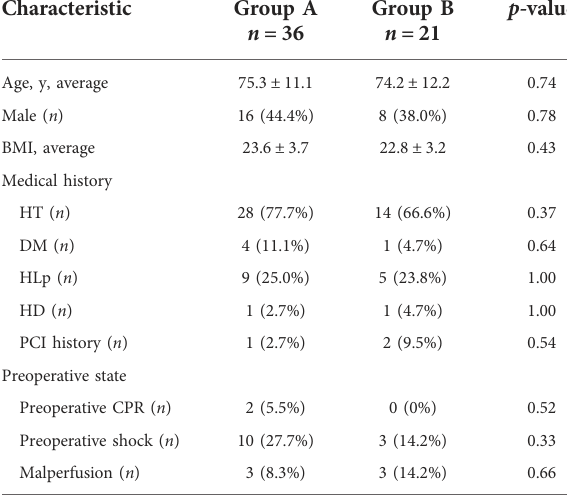
TABLE 1 Patient characteristics.